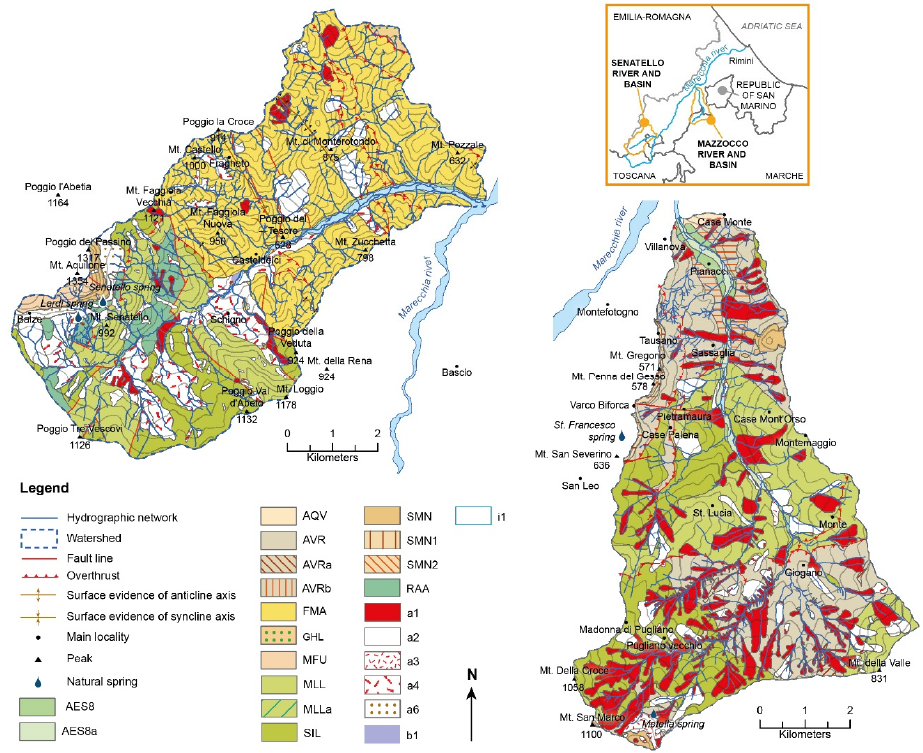
Figure 2. Geological maps of Senatello and Mazzocco river valleys.